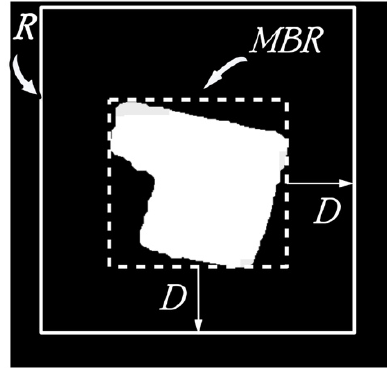
Figure 3. Schematic of block construction.